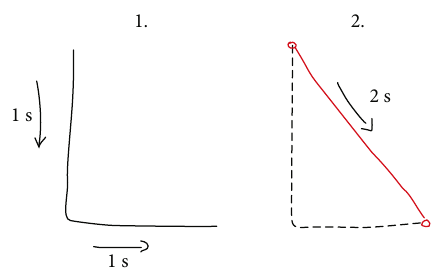
Figure 2: Distorted drawing due to